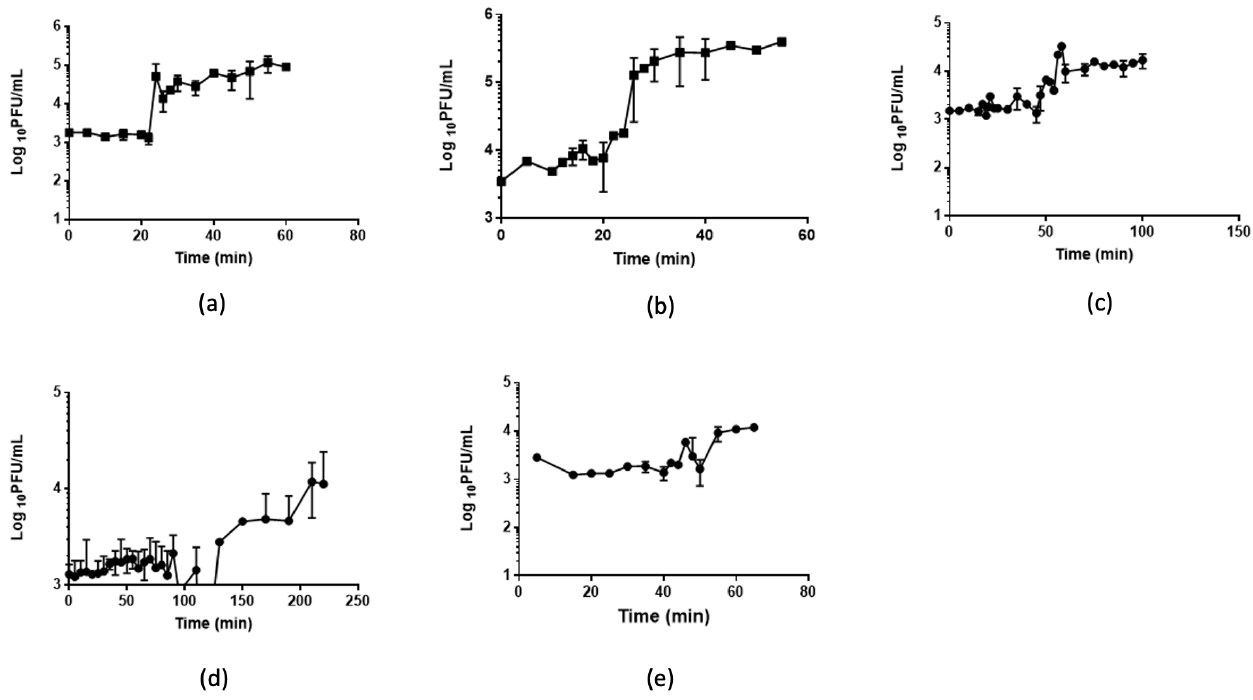
Figure 3. Growth kinetics. The figure shows the single-step growth curves of ( a ) phage A4, ( b ) phage A5, ( c ) phage A7, ( d ) phage A8, and ( e ) phage B3. Data shown are the mean of three replicates ± SD. Table 2. Kinetics parameters of phage infection in Salmonella Typhimurium ATCC 14028. Phage